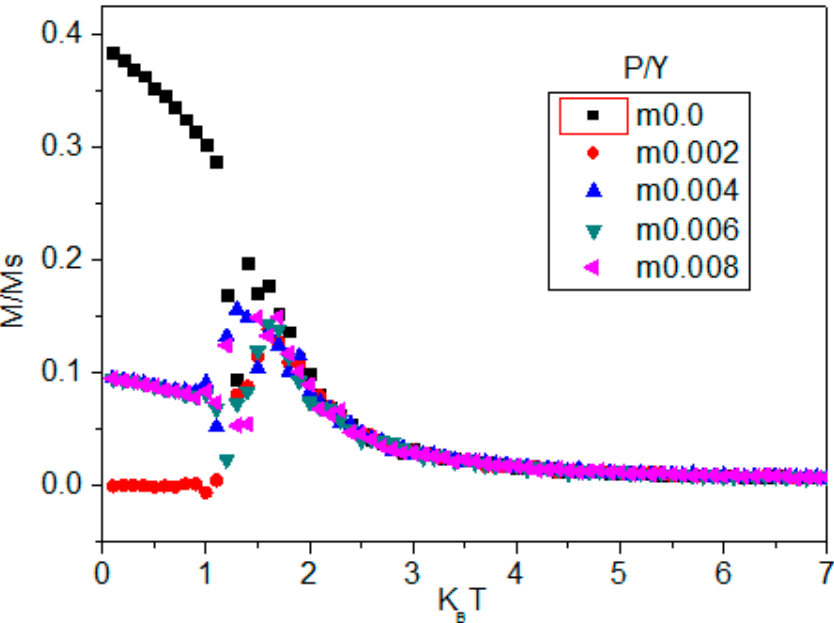
ff ect of pressure on the magnetization curve vs. temperature for a value g = Figure 4. Effect of pressure on the magnetization curve vs. temperature for a value g = 0.69. Figure 4. E